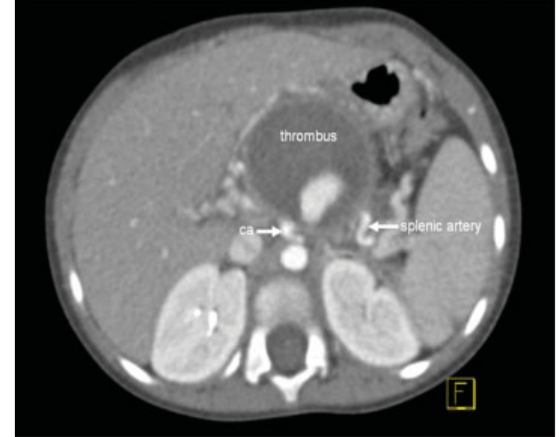
Fig. 2 CTA showing a large pseudoaneurysm arising from the splenic artery with an associated thrombus. ca, celiac axis; CTA, computed tomography angiography.